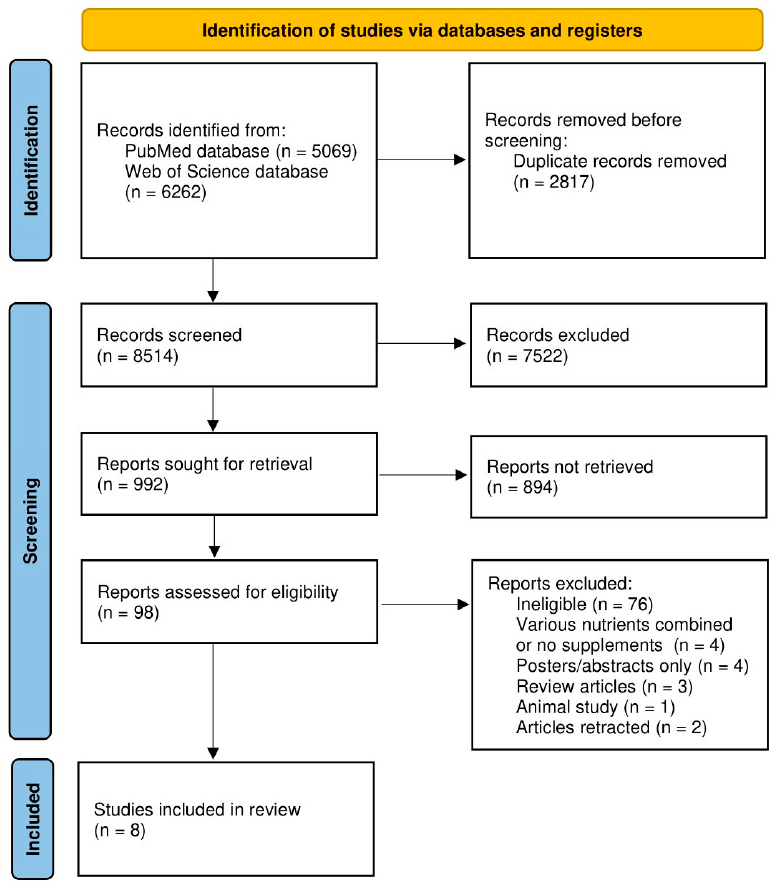
Figure 1. The procedure of identification, screening, eligibility assessment, and including studies.